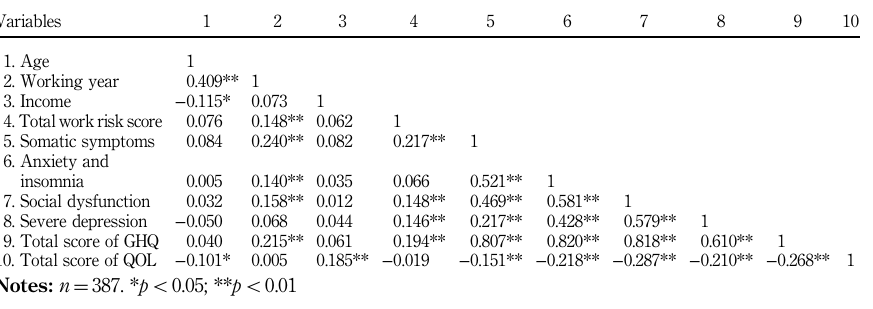
Table VI. Variables associated